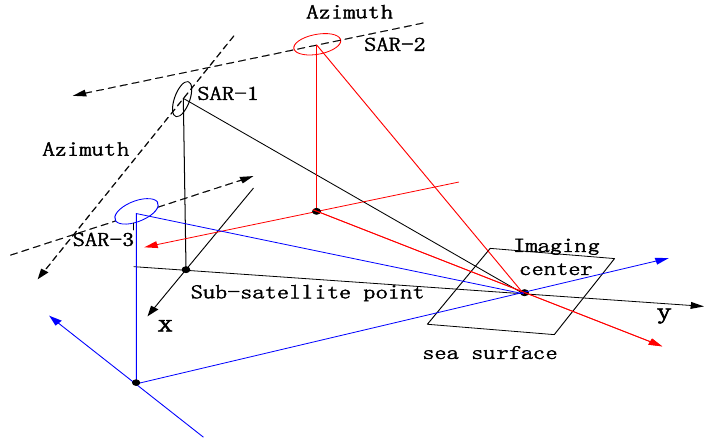
Figure 7. Networked SAR satellite observations of the same sea area.